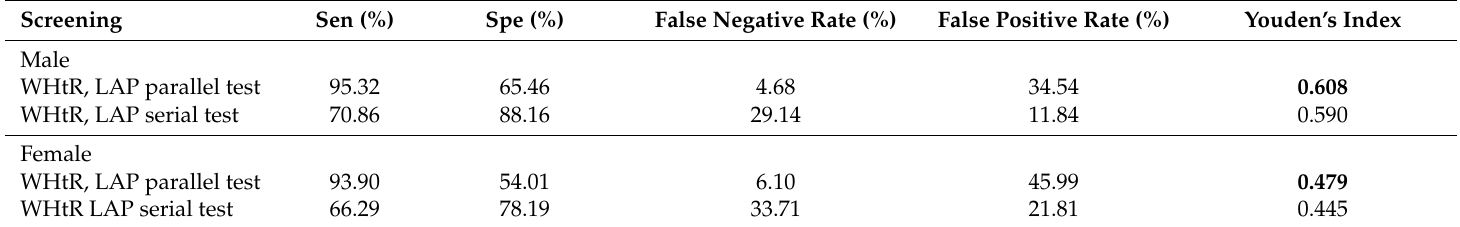
Table 4. The validity of WHtR, LAPin combination for the screening of MetS in a Kazakh population.